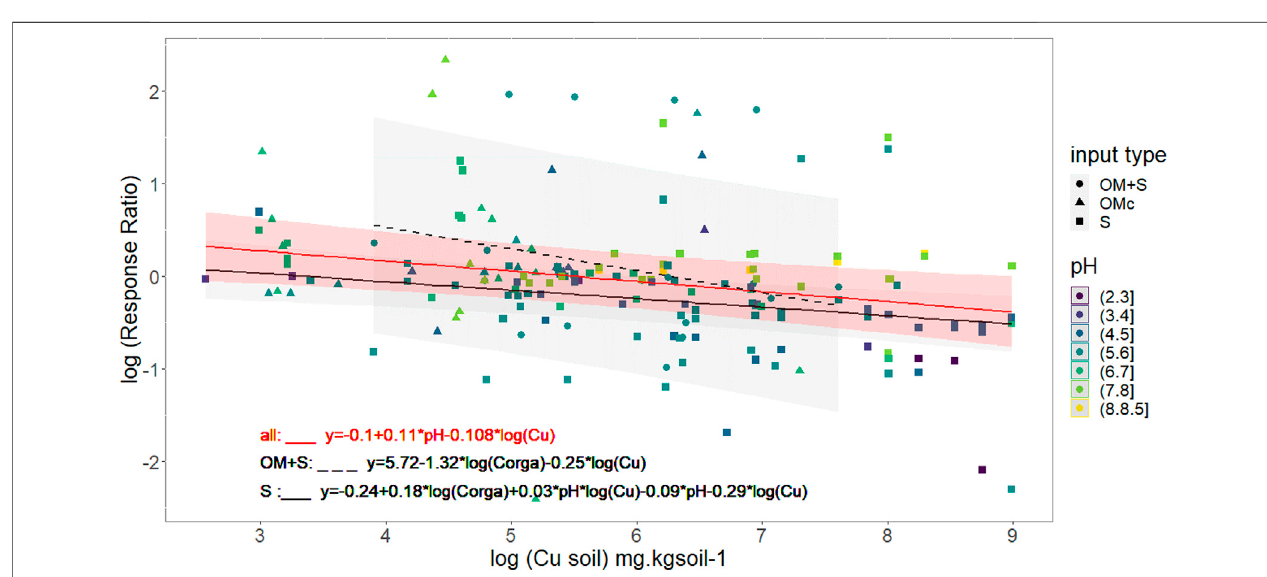
FIGURE4| VariationinsoilCmineralizationduetoarti fi cialcontamination.pHandnatureofarti fi cialcontaminationarerepresentedthroughcolorandshape.Black red line models soil Cu effect on log(ResponseRatio) for all supplementary contamination with median pH value (5.9), black fullline for Spike contamination with median pH and Corga (5.7 and 29.4 g. kgsoil − 1 ) value and black dashed line for organic matter + spike data with median Corga value (27 g.kg soil − 1 ). Mean Response Ratio are calculated according to Eq. (1) and soil respiration in contaminated condition is equal to control respiration for log(Response Ratio) (cid:2) 0 which is the grey dashed